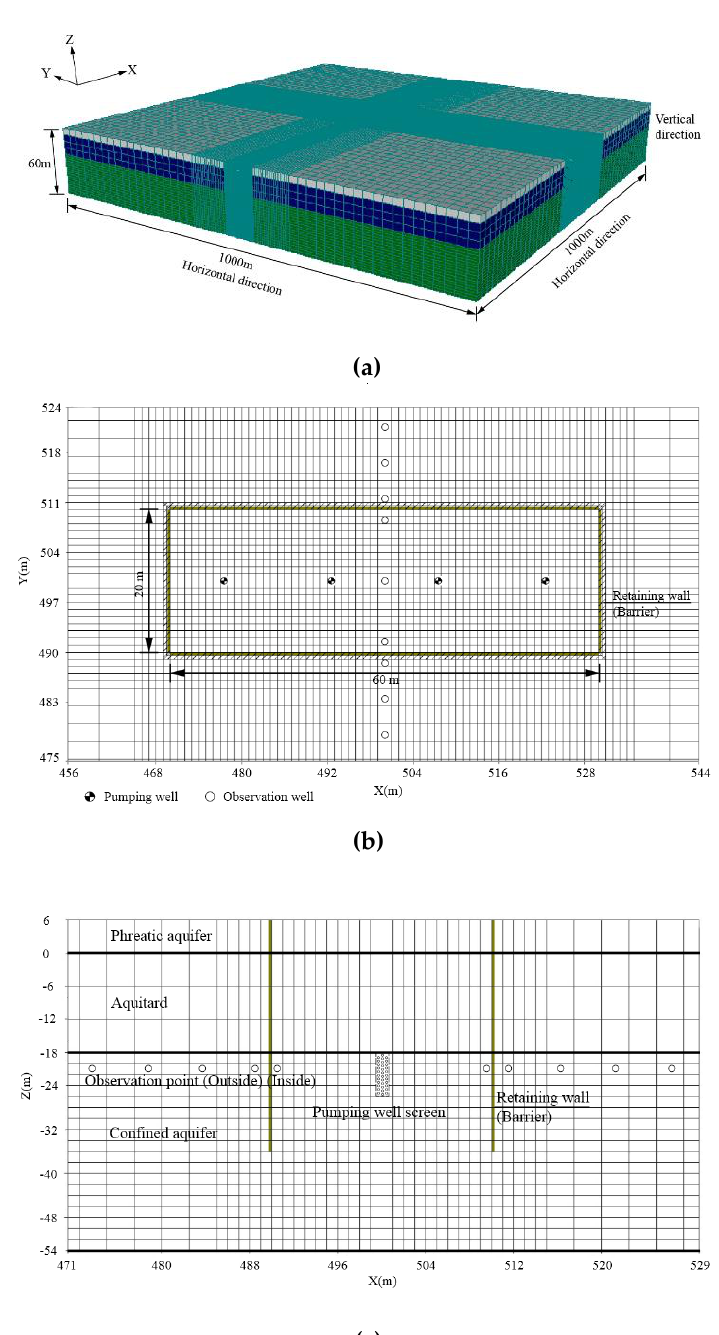
Figure 4. Finite difference mesh: ( a ) Three-dimensional (3D) view of the mesh; ( b ) plan view of the mesh around the pit; ( c ) central cross-section of the mesh. Table 2. Simplified parameters in the calculation model.